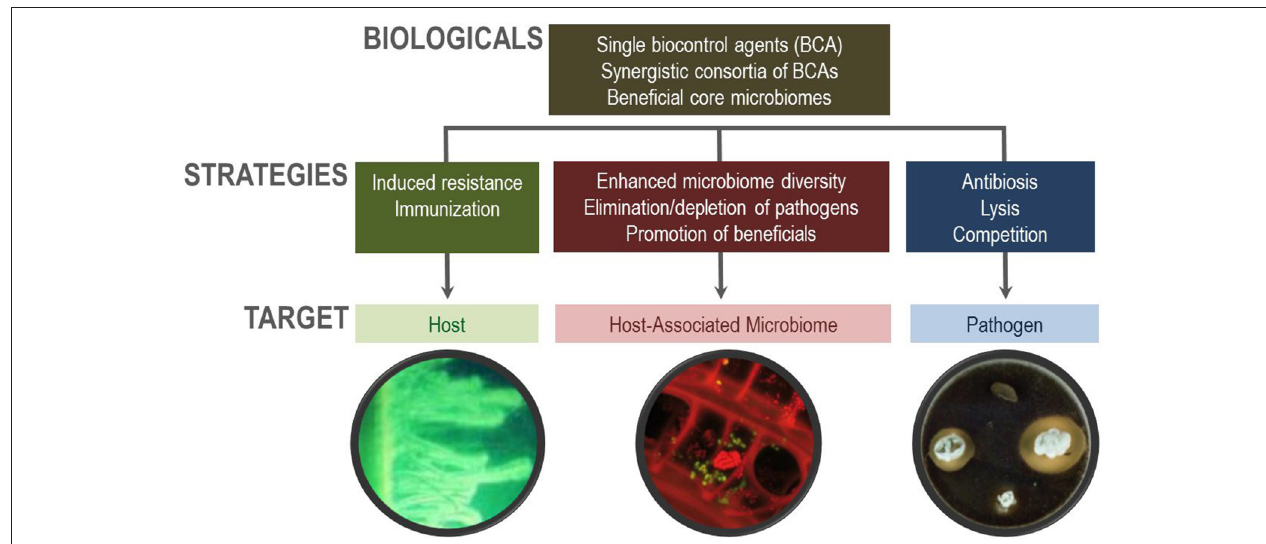
FIGURE 1 | Overview of various biocontrol